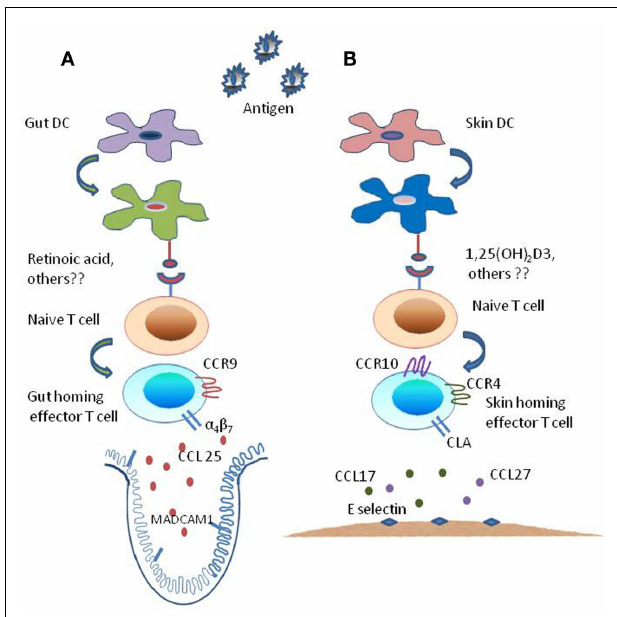
FIGURE 1 | Mechanism of generation of tissue specific effectorT subsets .The tissue-imprinting-receptors expressed on effectorT cells are induced by signals derived from regionally imprinted dendritic cells (DCs); expression of α 4 β 7 -integrin and CLA are induced at low levels onT cells activated by DCs, this expression of imprinting receptor-repertoire is regulated by factors that are explicitly produced by gut- and skin-derived DCs. (A) Mesenteric lymph node or Peyer’s patch dendritic cells, i.e., intestine derived DCs along with external cues (Vitamin A metabolite retinoic acid) generate CCR9 + and α 4 β 7 + gut-homing effectorT cells by inducing α 4 β 7 -integrin expression and CC-chemokine receptor 9 (CCR9) expression on respondingT cells while suppressing the expression of ligands for E-selectin. (B) By contrast skin-derived DCs along with external stimuli [Vitamin D 3 metabolite 1,25(OH) 2 D3] generate factors that enhance the expression of ligands for E-selectin and CC-chemokine receptor (CCR10 and CCR4) while suppressing the expression of α 4 β 7 -integrin and CCR9 resulting in the generation of CLA + and CCR4 + and CCR10 + skin homing effectorT